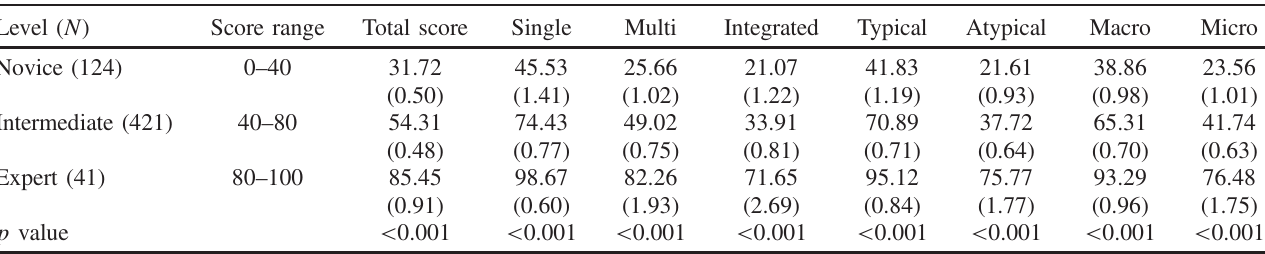
TABLE III. Summary of total score and question set scores for each knowledge integration level. Standard errors are given in brackets. The p values reflect the significance of the one-way ANOVA analysis for the differences among mean scores of the novice, intermediate, and expert students in each question